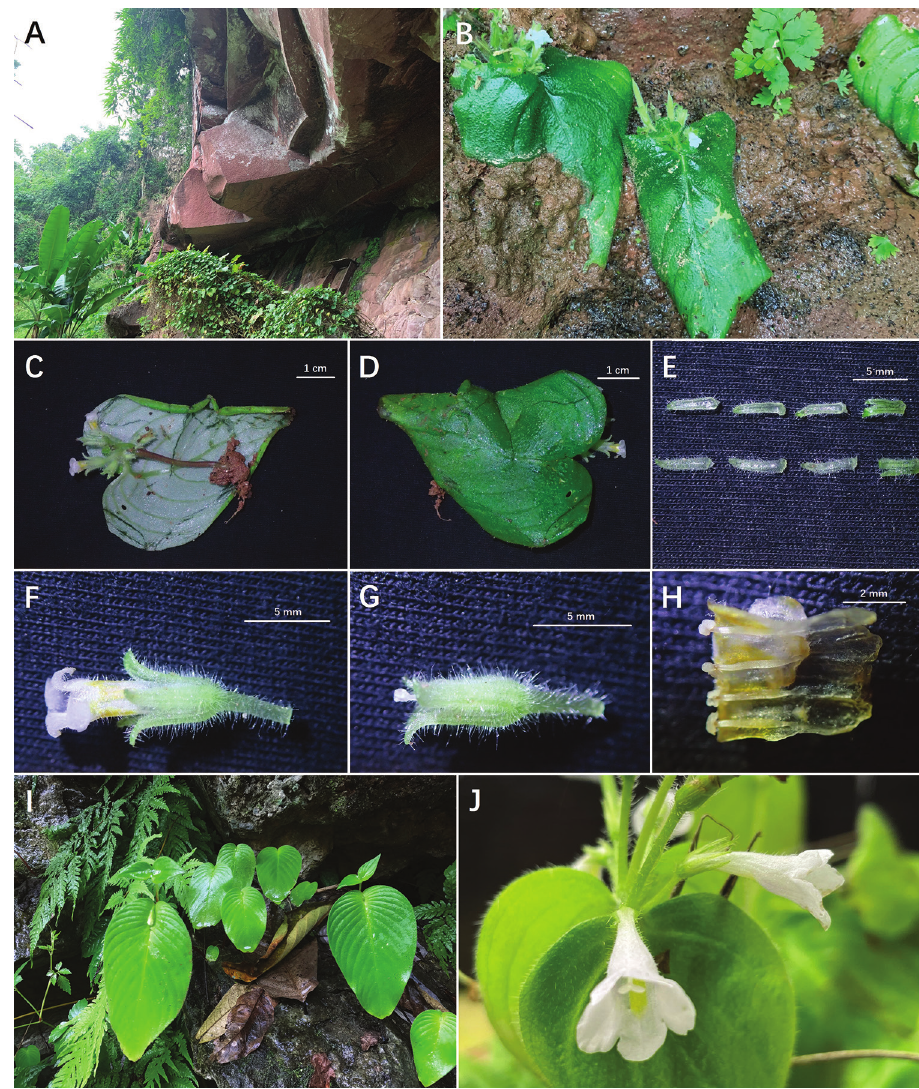
Figure 2. A–H Microchirita minor sp. nov. I–J M. hamosa A habitat B plants with flowers C abaxial surface of leaf blade D adaxial surface of leaf blades E calyx lobes (adaxial surface above, abaxial surface below) F lateral view of the flower G pistil and calyx H opened corolla with stamens and staminodes I habitat J plant with flowers. (Photos C–H from type